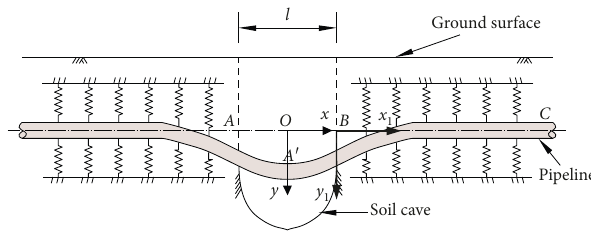
Figure 1: Calculation